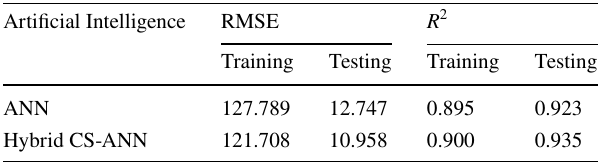
Table 1 RMSE and R 2 values for ANN and Hybrid CS-ANN at 10 years ahead of